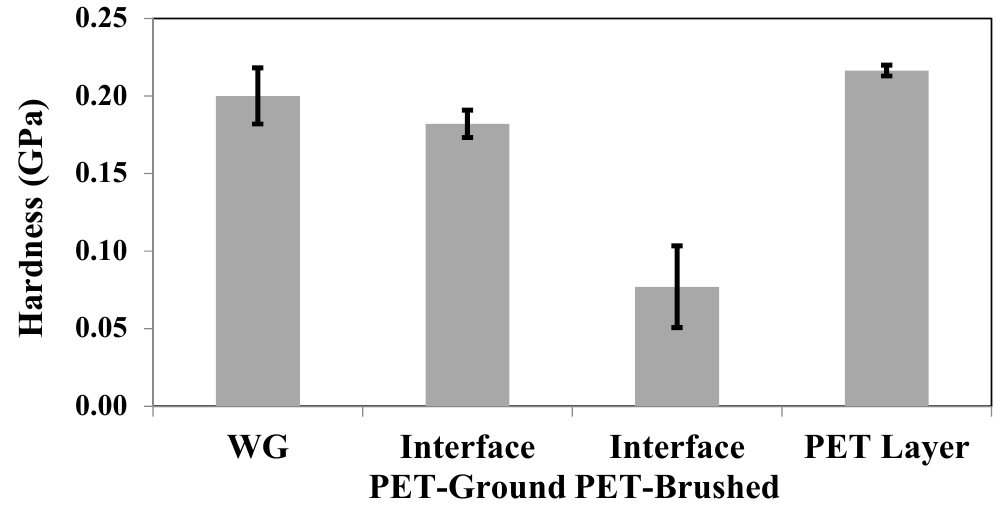
Figure 8. Nanoindentation hardness of the cross-sectional samples.